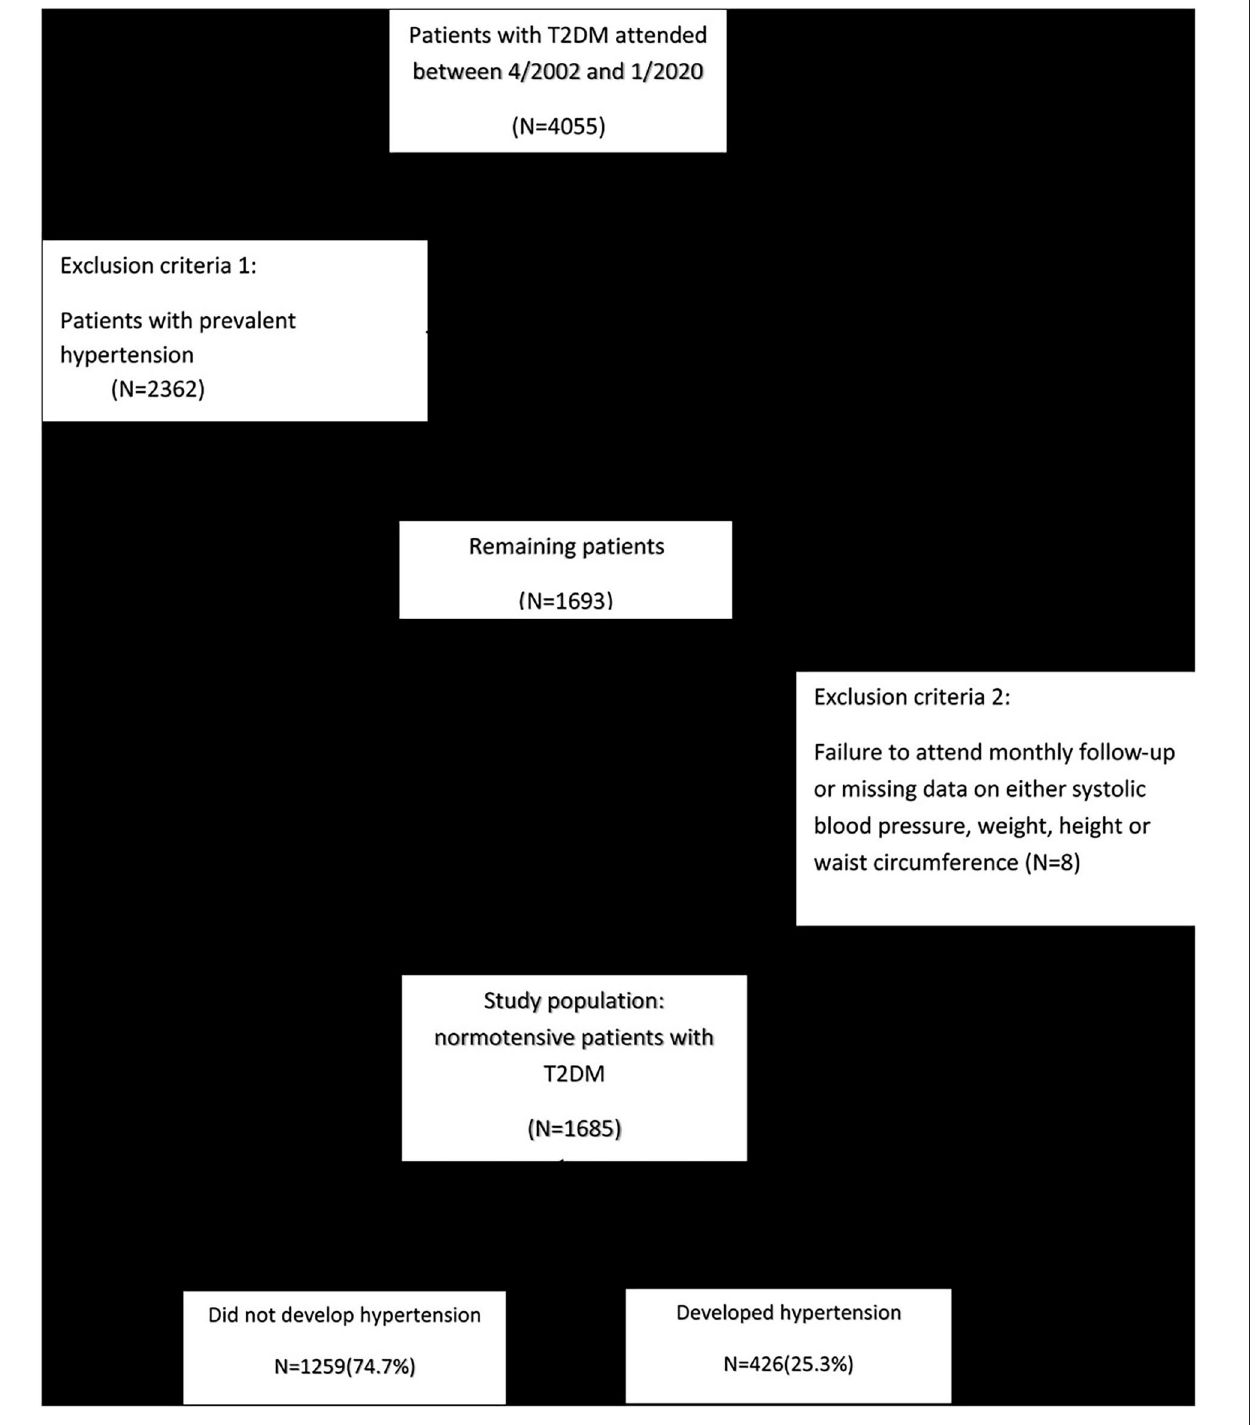
shoes. Height was measured using a standard protocol with a tape measure. The body mass index (BMI) was calculated as weight (kilograms) divided by squared height (m 2 ). The BMI